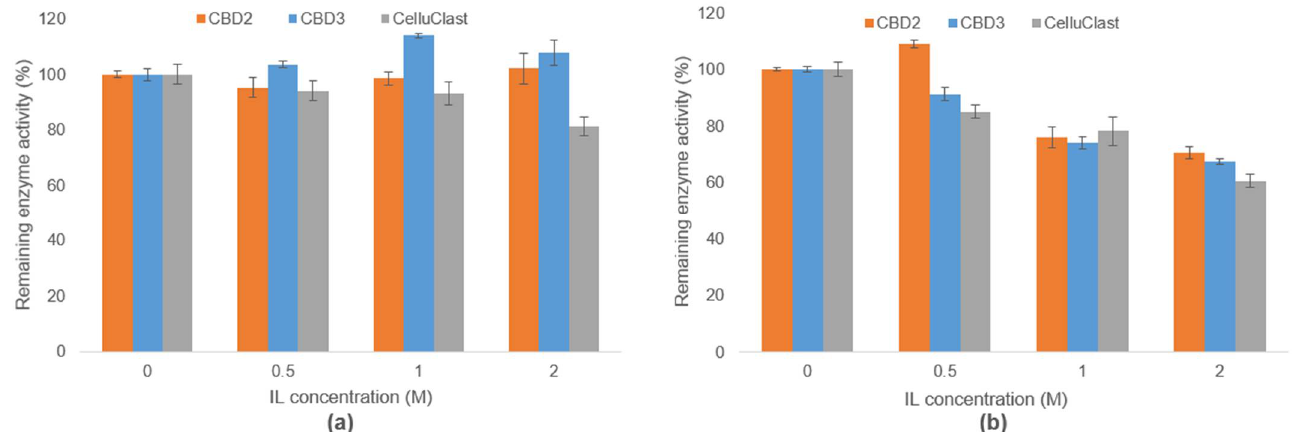
Figure 5. The remaining cellulase activities (CMCase) produced from CBD2 and CBD3 and commercial cellulase, Celluclast 1.5 L, under the influence of ILs, ( a ) [Ch][OAc] and ( b ) [EMIM][OAc].